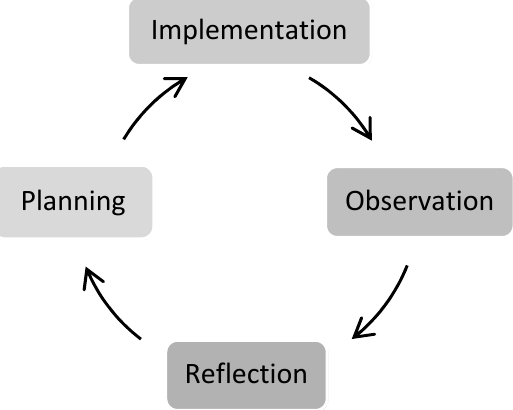
Figure 3. Four phases of action inquiry cycle according to [18].